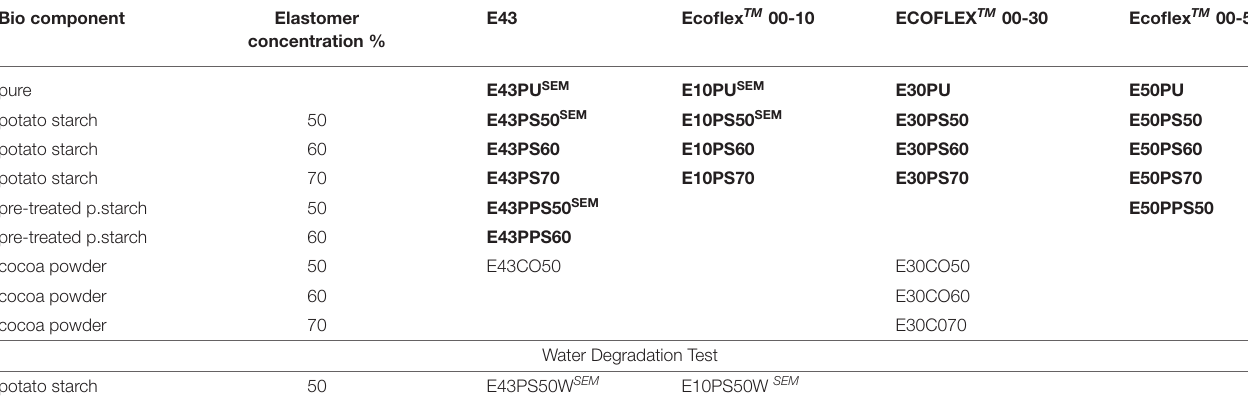
TABLE 1 | Sample Database. Samples made of elastomers and plant based ingredients. Bio